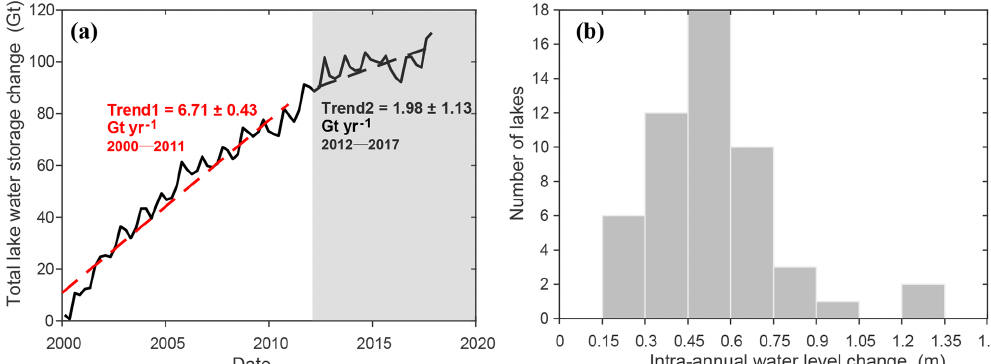
Figure 14. (a) Total storage changes in the 52 lakes on the TP, which can be generally divided into two stages: (1) a rapidly increasing stage (2000–2011) with a higher increasing rate of 6.71km 3 yr − 1 and (2) a mildly increasing stage (2012–2017) with an increasing rate of 1.98km 3 yr − 1 . (b) Histogram of intra-annual changes in lake water levels of the 52 lakes on the